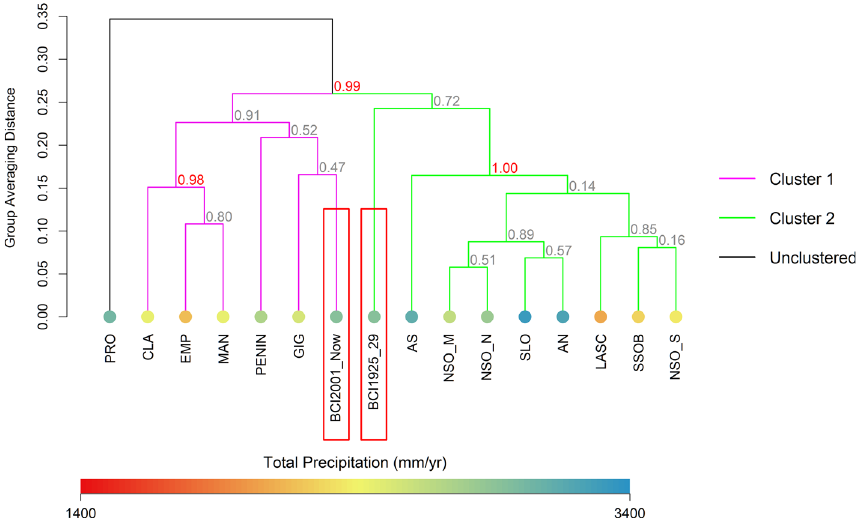
Figure 3. Hierarchical cluster analysis based on group average Sorensen distance. Values at nodes represent approximately unbiased (AU) probability of that cluster based on multiscale bootstrap resampling of the data for 10,000 runs. Red text indicates statistically significant clusters at p > 95%. Colored circles at dendrogram “leaves” correspond to total annual precipitation for that subregion. Colored lines denote independent clusters of subregions. The oldest and most recent bird inventories from BCI are indicated with red rectangles.